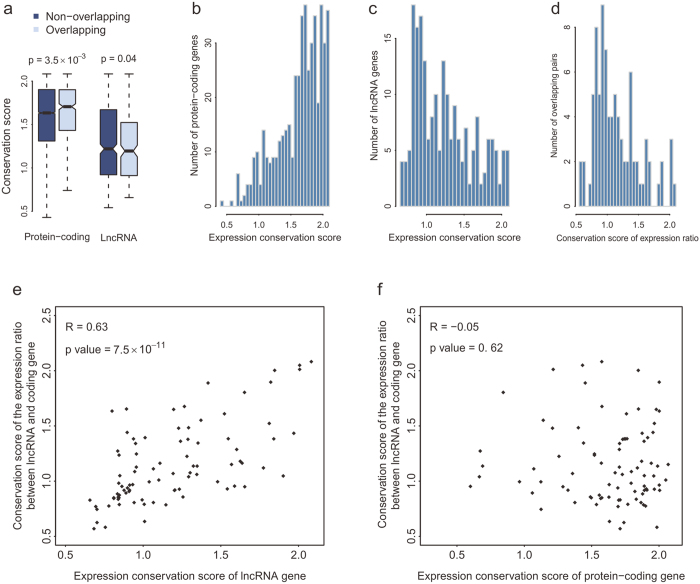
Expression conservation of lncRNA-coding pairs.(a) Expression conservation score of protein-coding and lncRNA genes. The conservation score ranges from 0 to 2 and values close to 2 represent highly conserved expression. (b,c) Distribution of expression conservation score of the protein-coding (b) or lncRNA (c) genes in lncRNA-coding pairs. (d) The conservation score of expression ratio of lncRNA-coding pairs. The expression ratio was calculated by the expression of lncRNA gene over its protein-coding overlapping partner. (e,f) The correlation between the expression ratio conservation and the expression conservation of lncRNA (e) or protein-coding (f) genes.